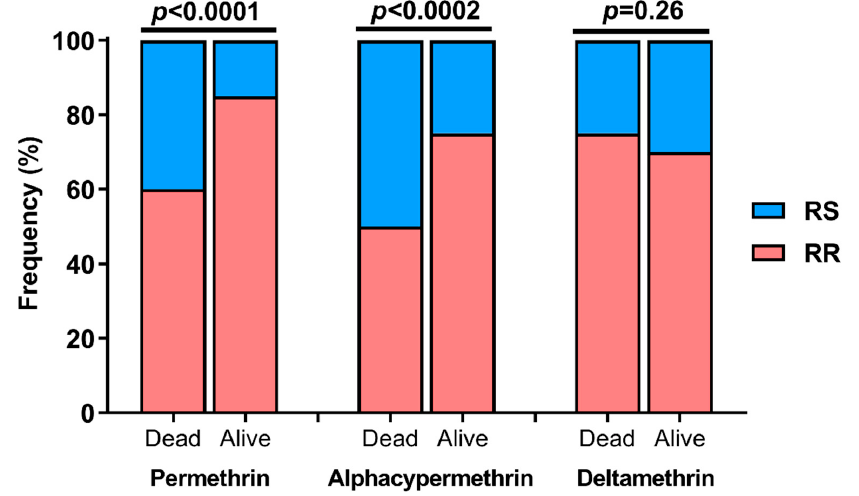
Figure 4. Level of association between the L1014F ( kdr -West) mutation and pyrethroids resistance (RR: homozygous resistant genotype; RS: heterozygous genotype).